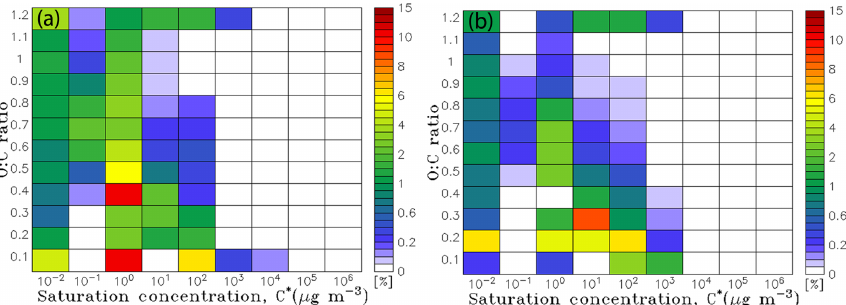
Figure 7. Predicted average fraction of OA concentration in each cell of the ORACLE 2-D grid space to total OA concentration over (a) Europe and (b) the Amazon basin during the years